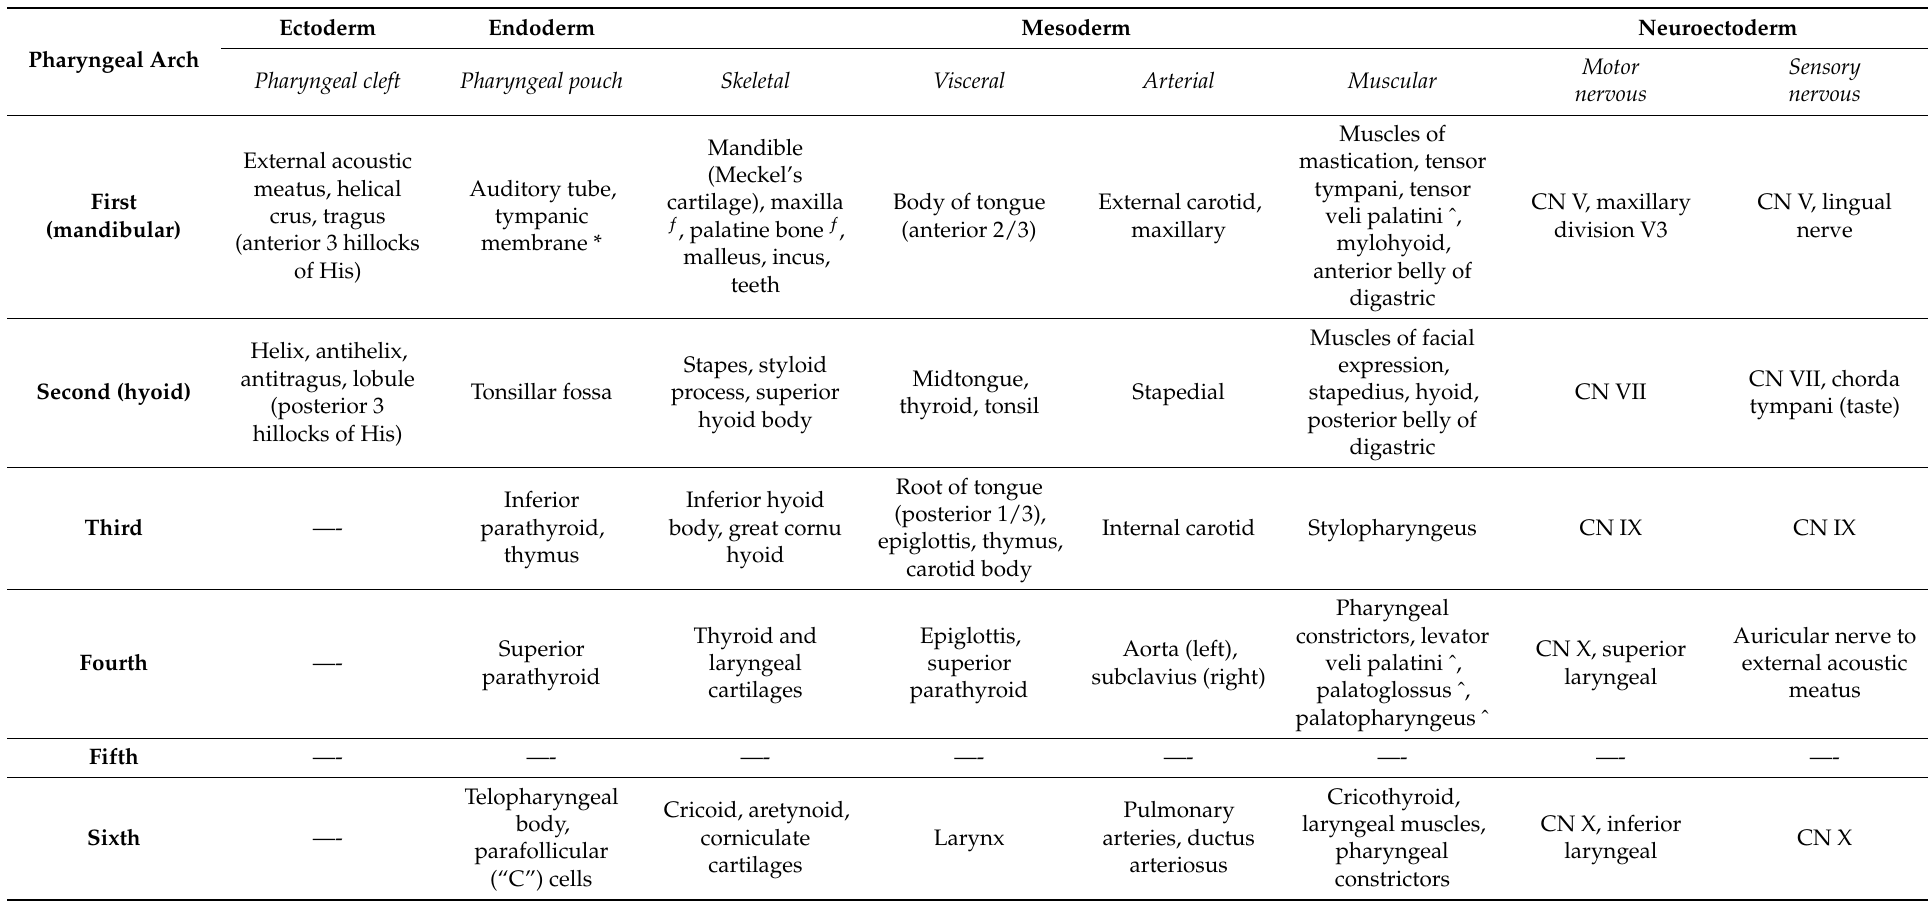
Table 1. Derivatives of pharyngeal